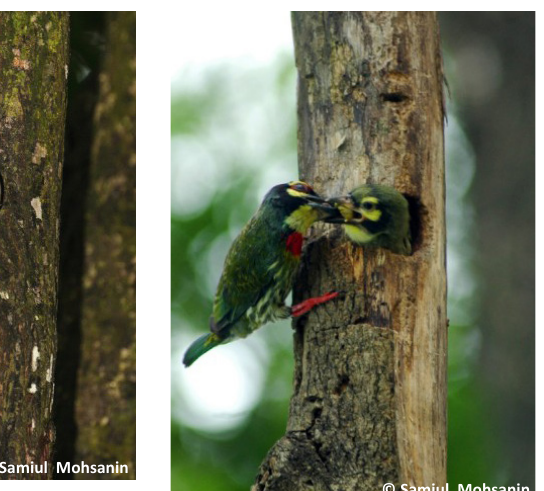
Image 19. Chestnut-tailed Starling feeding chicks